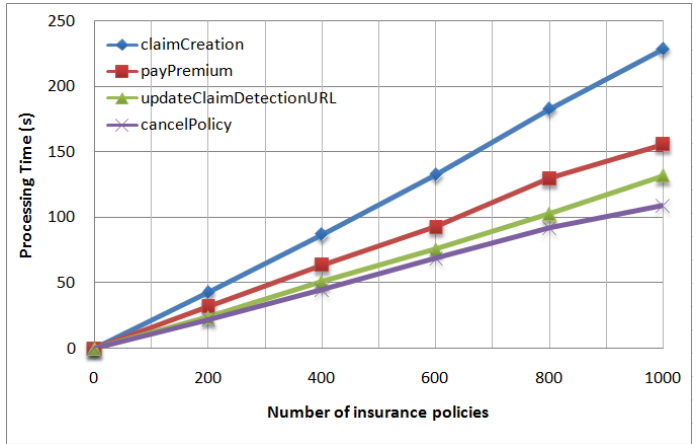
Figure 4. Computational cost for 1000 insureds’ insurance